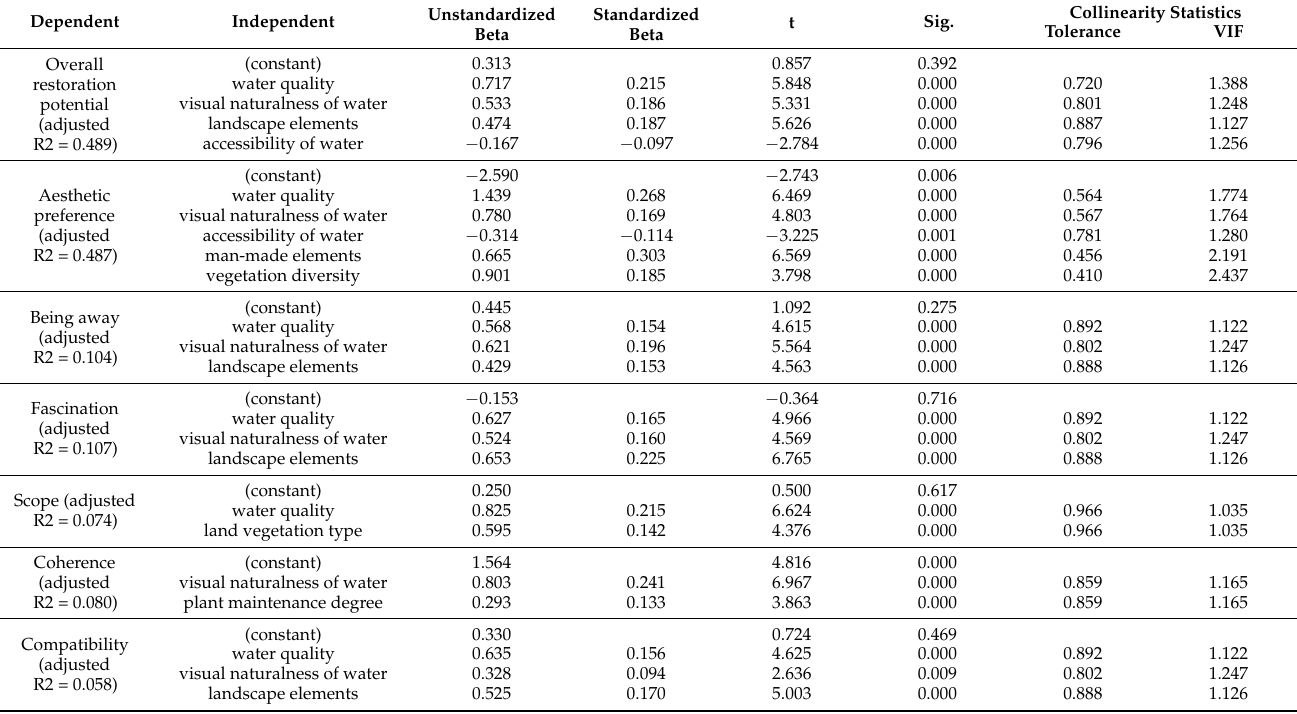
Table 7. Significant predictors of UPBS aesthetic preference and restorative